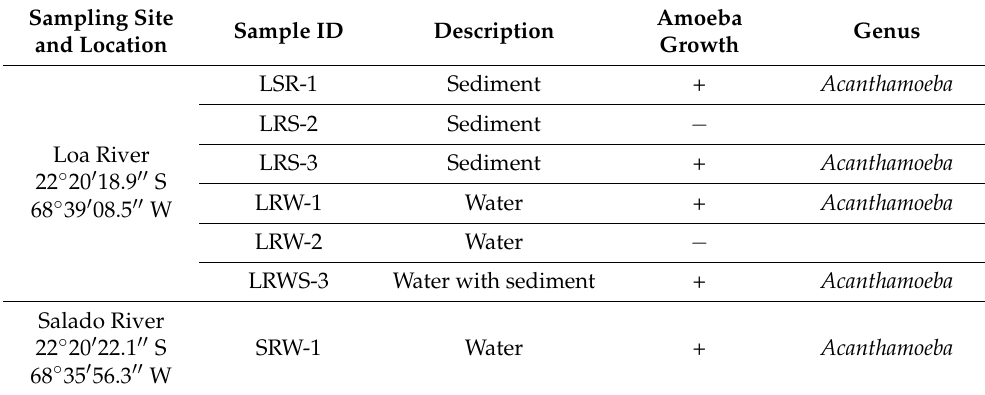
Table 1. Sampling sites, growth, and genus identification of free-living amoebae isolated from Salado and Loa rivers, Region of Antofagasta, northern